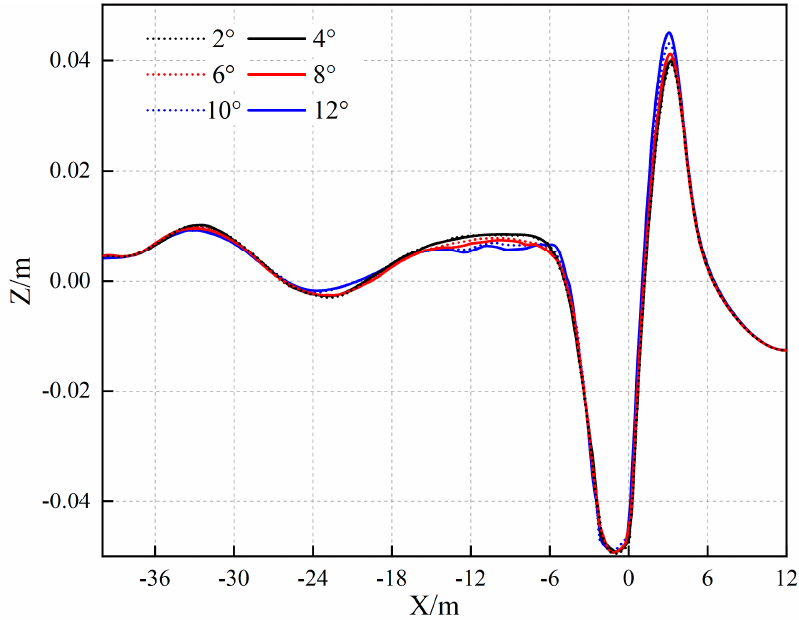
Figure 13 is the wave shear diagram of the longitudinal section of the free surface under different drift angle conditions. It can be seen from the figure that under different drift angles, the amplitude changes are quite varied, and the wavelength does not change. It can be concluded that when the underwater vehicle moves in stratified fluid, the drift angle change does not affect the wake wavelength of the underwater vehicle.